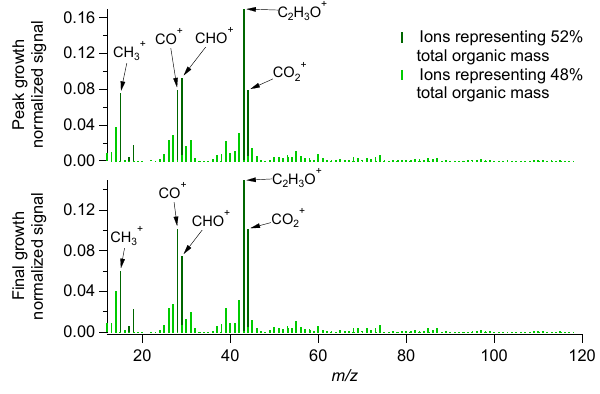
Fig. 6. Average AMS high-resolution organic mass spectra at the time of peak growth and at the end of the experiment (final growth) for the 36-h aging experiment. Prominent peaks are identified. The mass of CO + is estimated to equal that of CO +